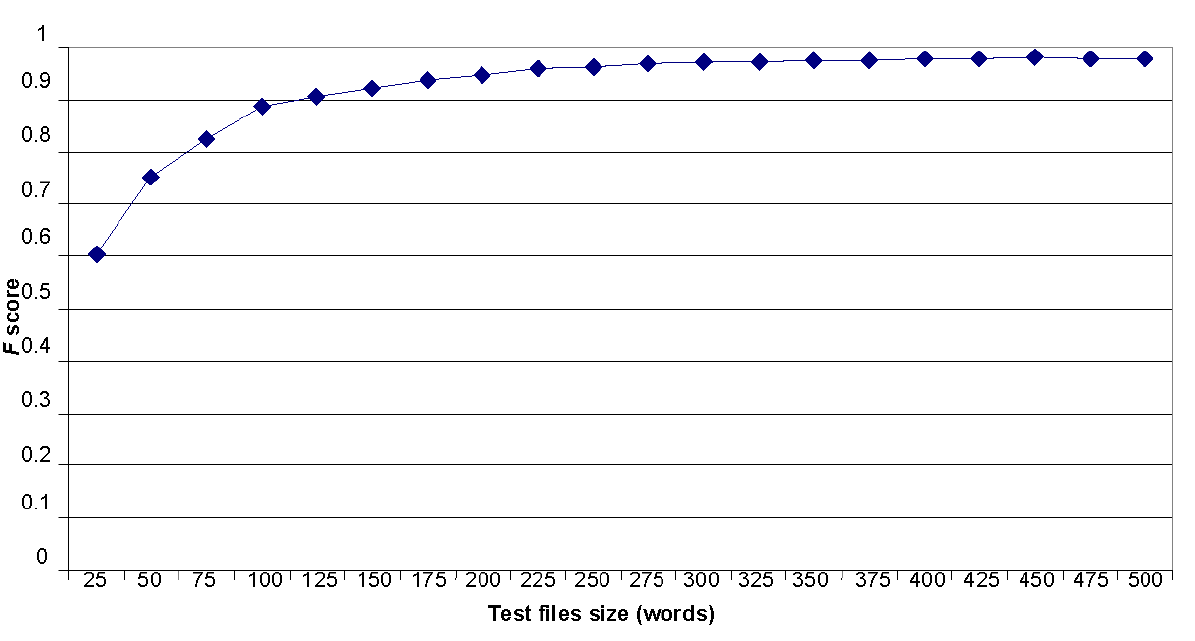
F scoreFeaturesSubforum SVMNaïve